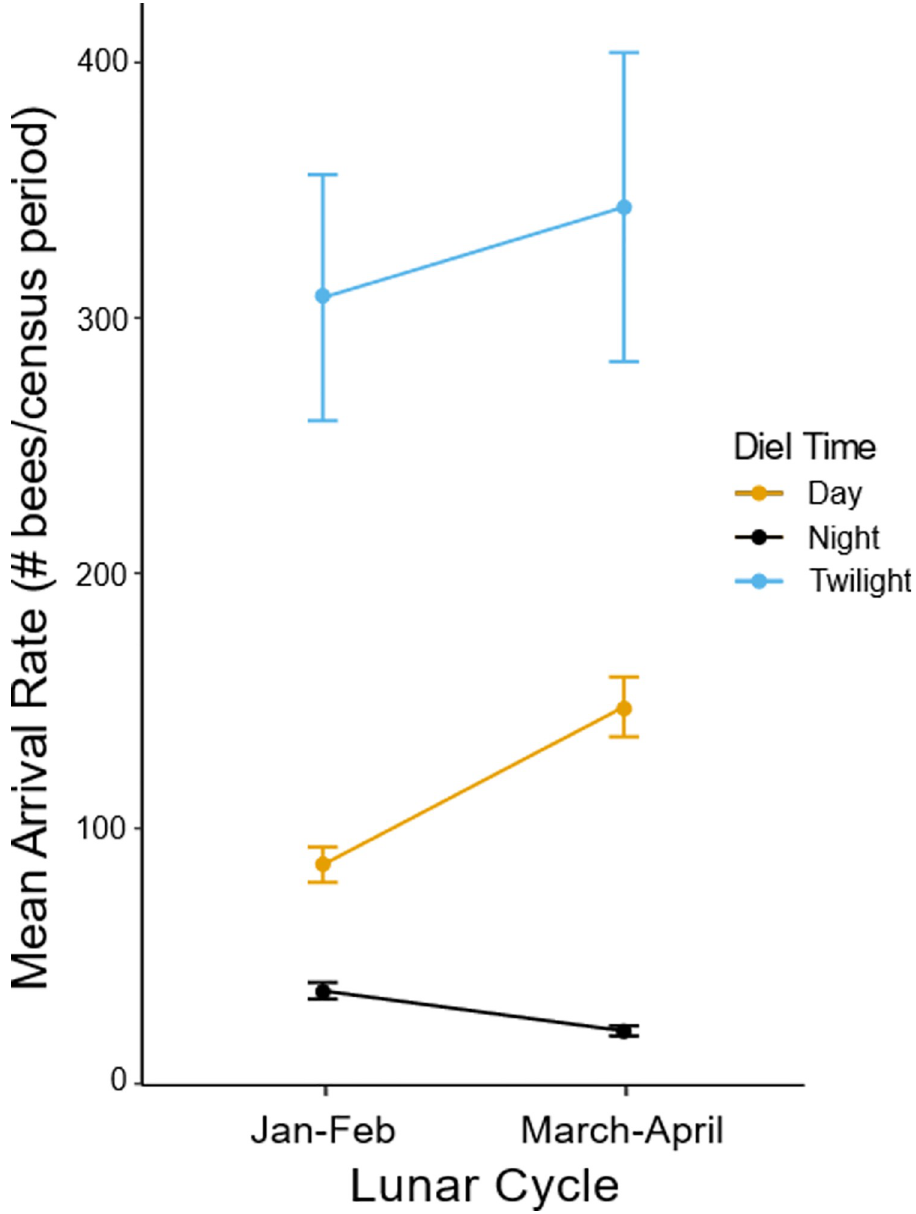
Fig 6. Estimated marginal mean arrival rates in each lunar cycle. Estimated marginal mean arrival rates during each diel time over both lunar cycles are shown. In both lunar cycles the highest number of arrivals were seen during twilight ( P < 0.001), and the least number of arrivals were seen during the night ( P < 0.001). An interaction was seen where nocturnal activity decreased but diurnal activity increased from the January lunar cycle to the March lunar cycle ( P < 0.001). Error bars represent 95% confidence intervals. Data shown here stem exclusively from observations of A . dorsata Colony 4, and include only data collected during the lunar cycle observation periods from January 21, 2019 – February 19, 2019 and March 21, 2019 –April 19, 2019. both lunar cycles, with nocturnal activity the lowest in both cycles ( P < 0.001 all). Data for both moon phase and lunar cycle analyses stem exclusively from observations of A . dorsata